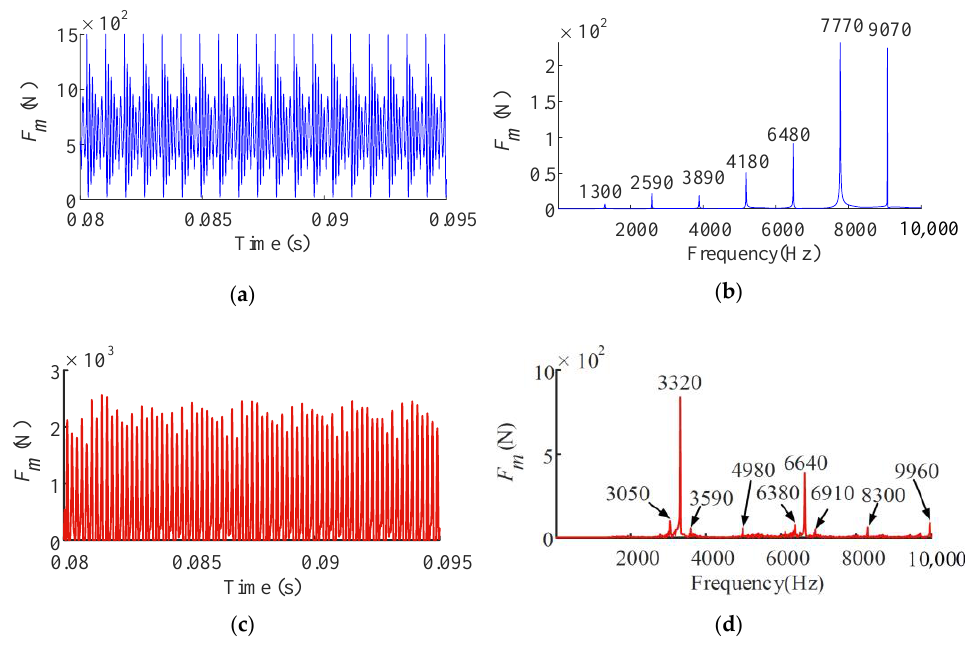
Figure 7. Comparison of dynamic mesh force: ( a ) time domain of epoxy gear pair, 3380 r/min; ( b ) frequency domain of epoxy gear pair; ( c ) time domain of steel gear pair, 4330 r/min; ( d ) frequency domain of steel gear pair.